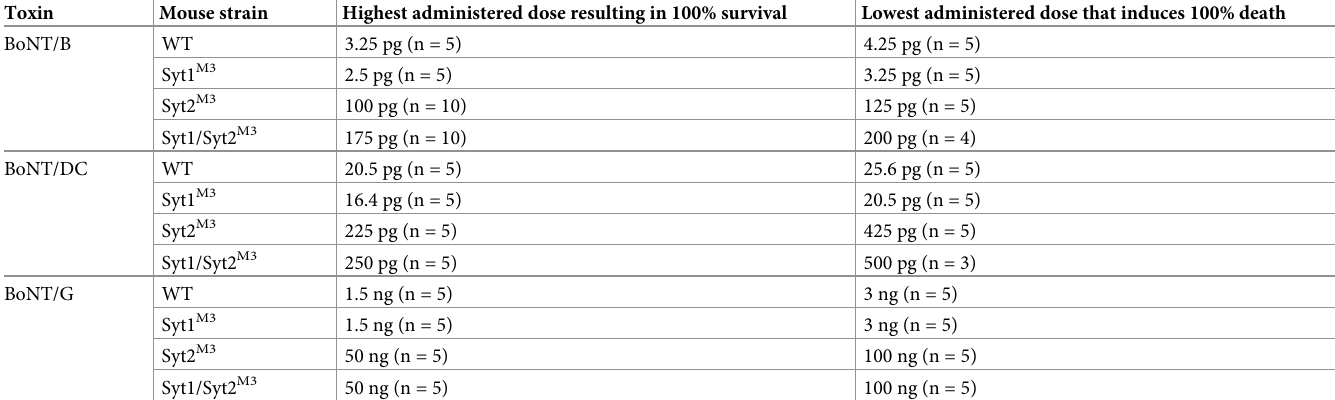
Table 1. A list of toxin doses correlating with systemic toxicity in WT and KI mice. The full ranges of titration toxin doses and survival rates are shown in Figs 3F, 4B and 4D. Toxin Mouse